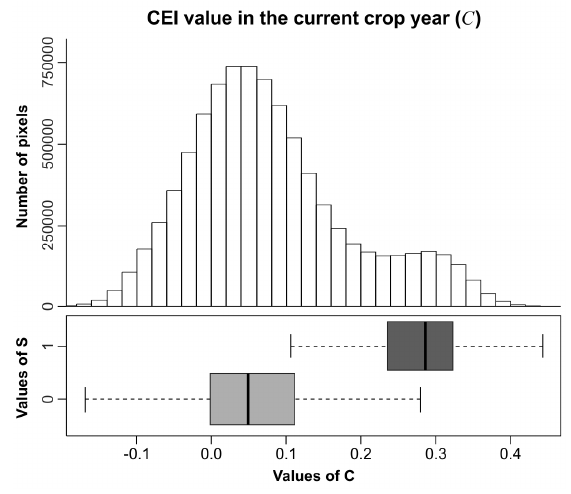
Figure 7. Histogram of CEI values observed in the current crop year ( C ) and boxplot showing the strong relationship between soybean presence ( S = 1) and C greater than